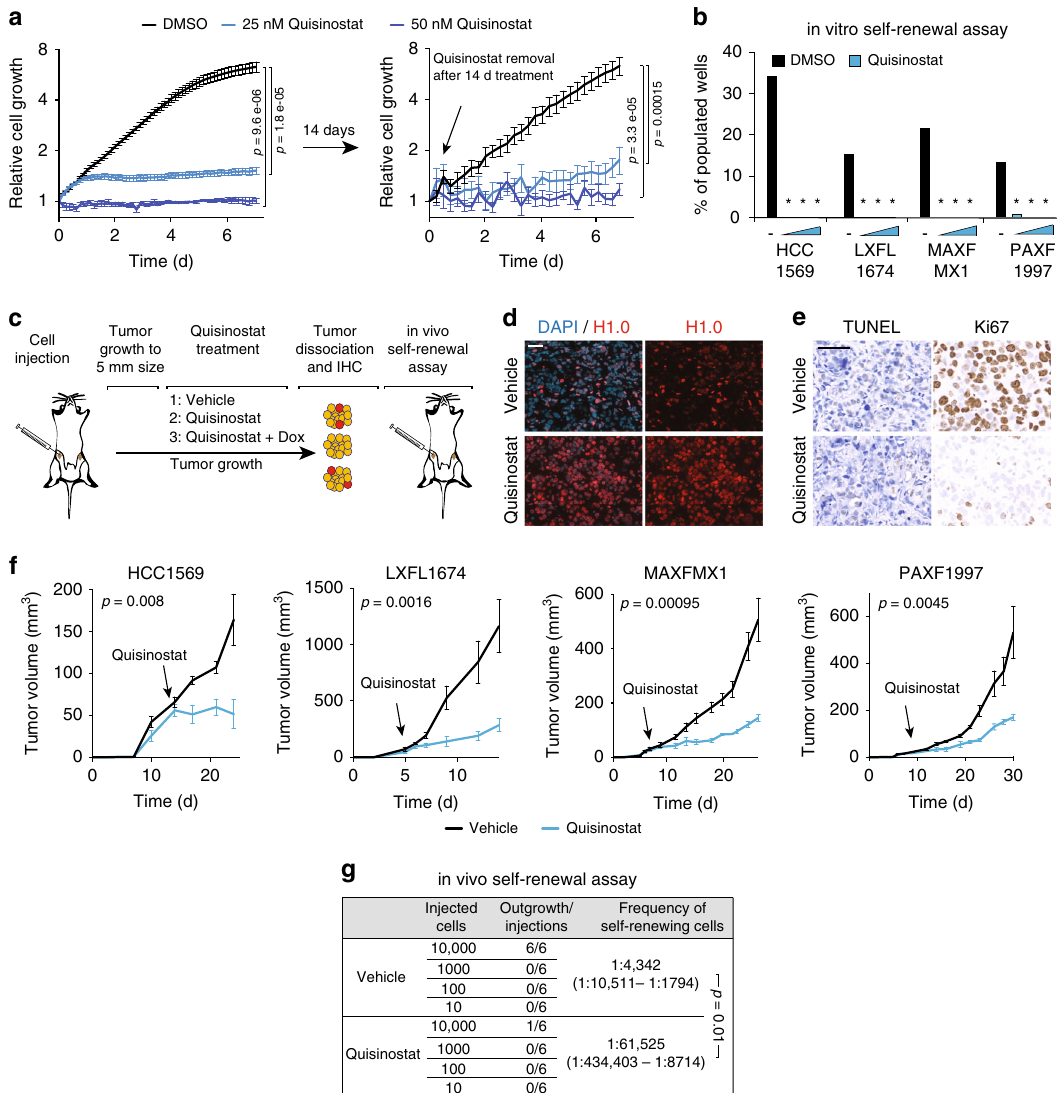
Fig. 2 Quisinostat inhibits cancer cell self-renewal and drives differentiation. a IncuCyte proliferation assay on HCC1569 cells treated with Quisinostat for 7 days (left), or grown in the absence of the drug after a 14 d treatment. Values represent mean ± s.e.m. from four (left) or six (right) biological replicates. p -value: one-tailed Student ’ s t -test calculated at the last time point. TDF cells showed similar kinetics. b Clonogenic assays measuring self- renewal ability of the indicated cells. The percentage of wells ( n = 96) populated by colonies is indicated. Cells were plated at limiting dilutions and treated with DMSO (black dash), or Quisinostat (12.5, 25, 50 nM, blue triangle). * p -value < 0.001 comparing respective DMSO- and Quisinostat-treated cells (two-way contingency table analysis and two-tailed Fisher ’ s exact test). Exact p -values in Source Data fi le. c Experimental design to assess the in vivo effect of Quisinostat. 1, 2 and 3 indicate different mice groups treated with the indicated substances. Group 3 relates to Fig. 4 where doxycycline (Dox) was used to induce H1.0 knockdown. IHC: immunohistochemistry. Red, yellow: self-renewing and non-self-renewing tumor cells, respectively. d Immuno fl uorescence microscopy of HCC1569-induced tumors. See also LXFL1674 in Supplementary Fig. 3g. Similar results were obtained in three tumors and with other PDXs. Scale bar: 50 µ m. e Immunodetection of proliferating (Ki67 + ) and apoptotic (TUNEL + ) cells by immunohistochemistry in treated tumors. Similar results were obtained in three tumors. Scale bar: 50 µ m. f Tumor maintenance assay. Growth kinetics of HCC1569-induced tumors and the indicated PDXs treated with Quisinostat or vehicle. Arrow: start of Quisinostat treatment. Values are mean ± s.e.m. from four (HCC1569) or six tumors (PDX). p -value: one-tailed Student ’ s t -test calculated at the last time point. Three signi fi cant outlier tumors were excluded from the analysis (see source data). g Limiting-dilution transplantation assay into NSG mice using the indicated number of cells from Quisinostat- and vehicle-treated HCC1569- induced tumors. Despite the large con fi dence interval of the frequency estimate, due to the appearance of tumors at only one cell dose, differences are signi fi cant ( p = 0.01 χ 2 test). Data for all graph are in Source Data fi (Supplementary Fig. 5a, h – j). H1.0 knockdown also counteracted the effect of Quisinostat in clonogenic assays, indicating that H1.0